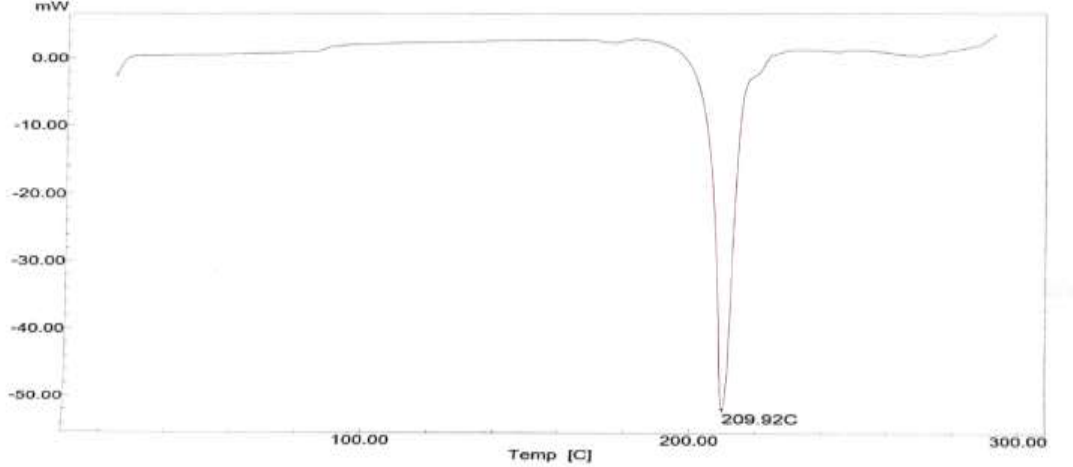
Figure 5. DSC thermogram of pure